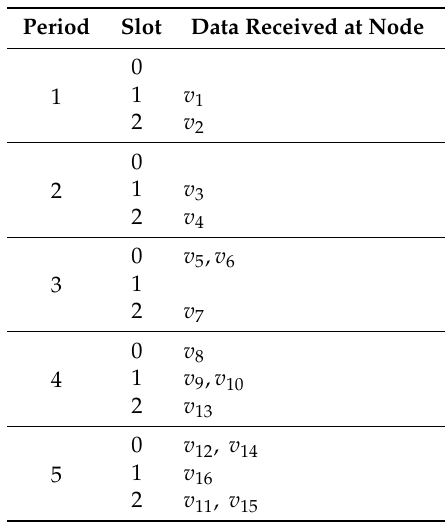
Table 2. Data packet dissemination using LBAS.